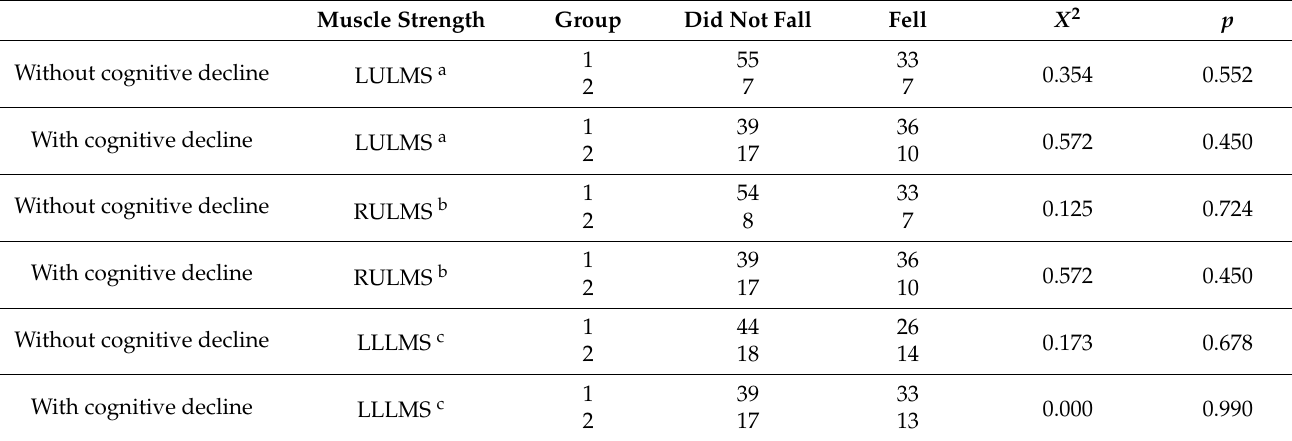
Table 4. Results of the application of the chi-square test to muscle strength of the older persons regarding occurrence of a fall episode over the year that followed the first